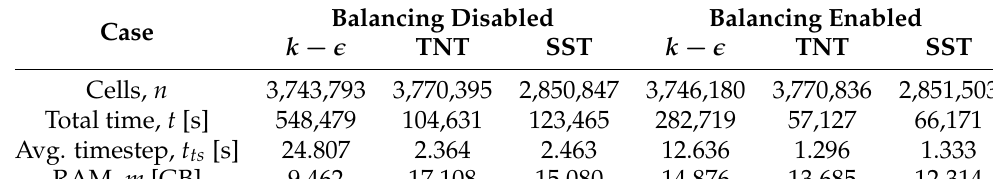
Table 3. Impact of load balancing on computational efficiency when using AMR.